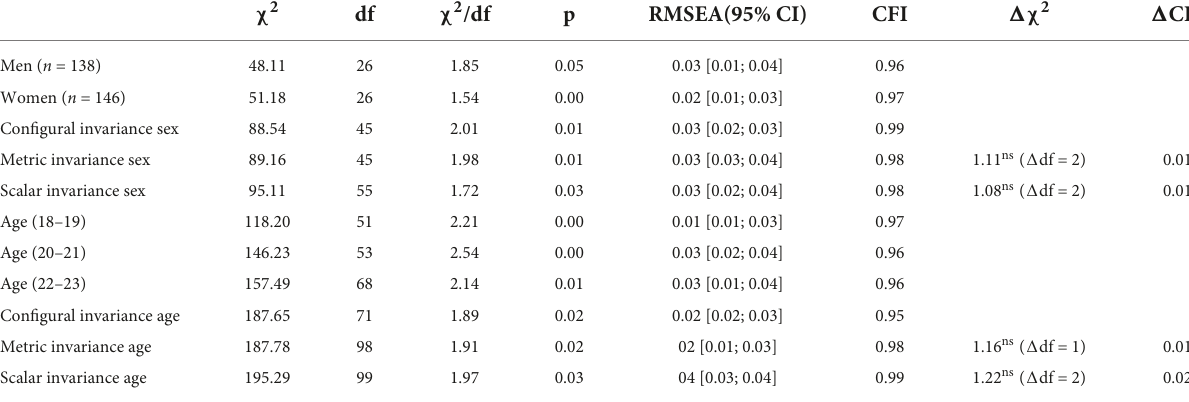
TABLE 4 Indices of fit for invariance tests by sex and age.